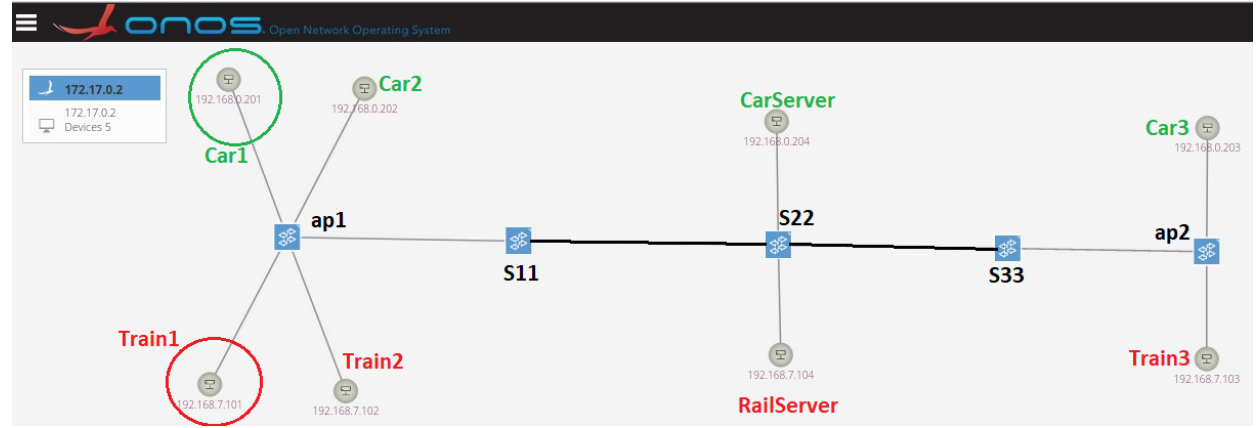
Figure 8. S4(5/6)4: Shared Access Network and Shared Core, Track Perpendicular to Road Topology: ONOS screenshot.